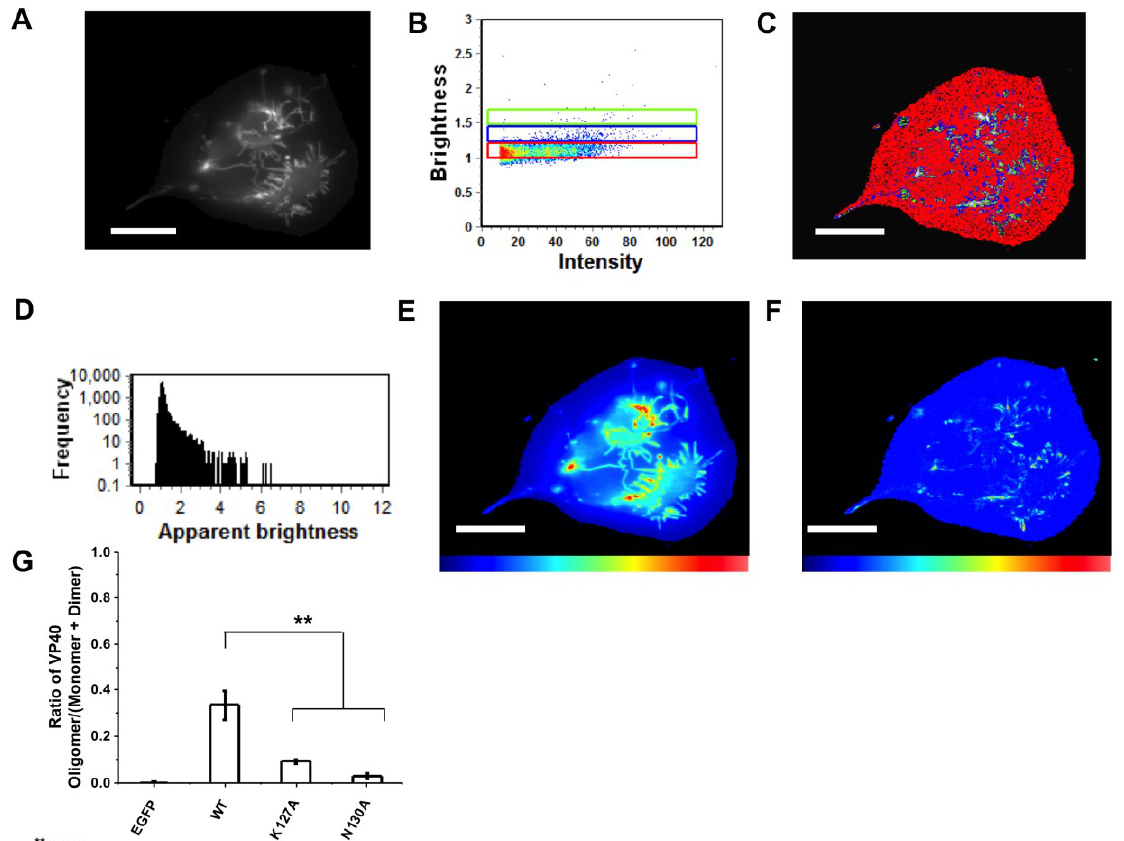
Figure 4. N&B Analysis of monomeric EGFP. ( A ) TIRF microscopy was used to image monomeric EGFP expressed in HEK293 cells; ( B ) Brightness versus intensity plot displaying monomers (red box); ( C ) Brightness distribution of EGFP near the PM displaying monomers (red) highlighted in B; ( D ) Frequency versus apparent brightness plot demonstrates a tightly correlated monomeric EGFP; ( E ) TIRF intensity image displaying monomeric EGFP distribution near the PM (blue = least intense; red = most intense); ( F ) Cellular brightness map of monomeric EGFP from the TIRF image (blue = least intense; red = most intense). Scale bar = 18 µm.